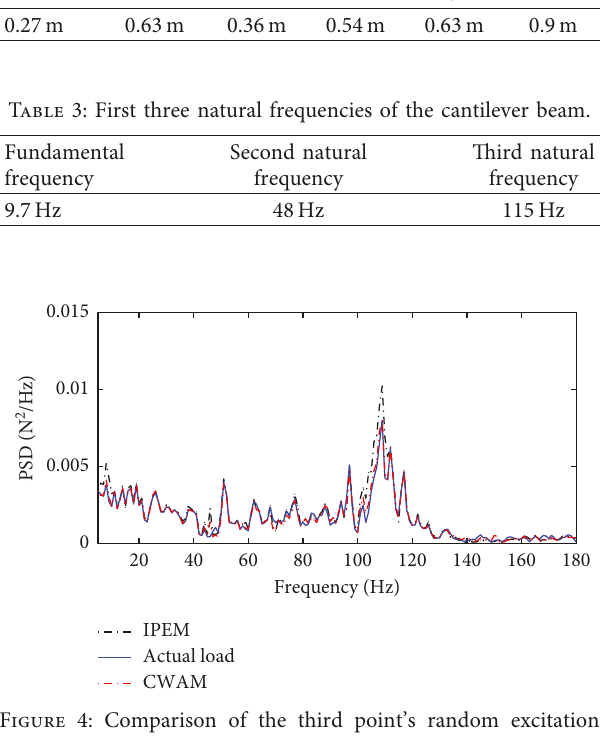
Figure 4: Comparison of the third point’s random excitation identification results.